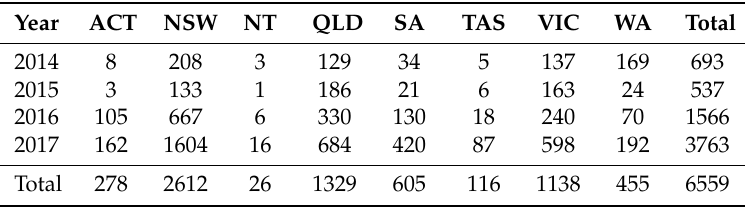
Table 1. Installed capacity of PV with battery storage (no. of